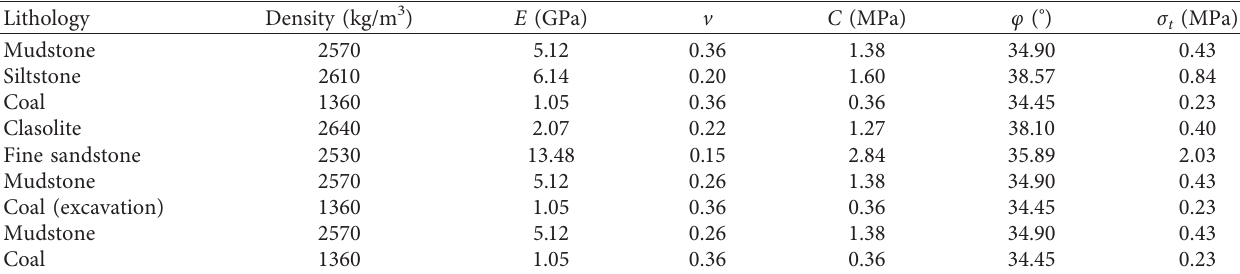
Figure 3: Configuration of the longwall model using the UDEC BBM approach. Table 1: Properties of coal and rock block in the